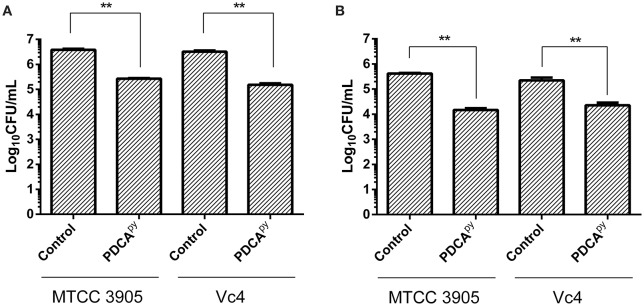
Anti- adhesion and anti- invasion effect of PDCApy treated V. cholerae onto INT-407 monolayer cells. (A) Adhesion data showing significant reduction in the number of adhered V. cholerae onto the intestinal epithelial cells when treated with PDCApy. (B) Invasion results where the number of invaded cells enumerated was significantly reduced in the case of PDCApy treated bacterial cells. **Indicates significantly different (p ≤ 0.01) compared to untreated control.